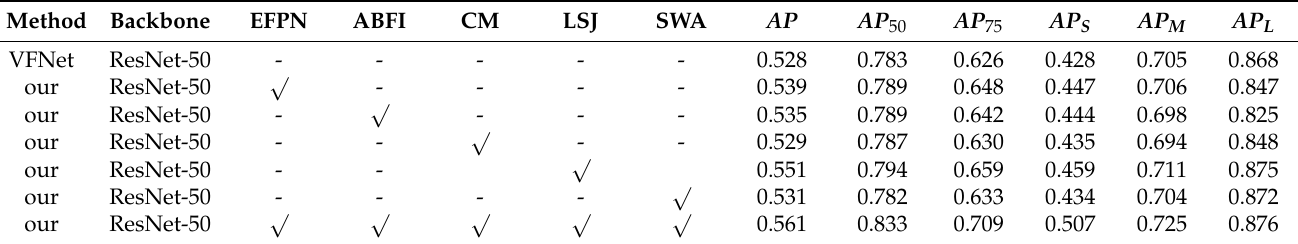
Table 2. Ablation experiment of the components on the DIOR